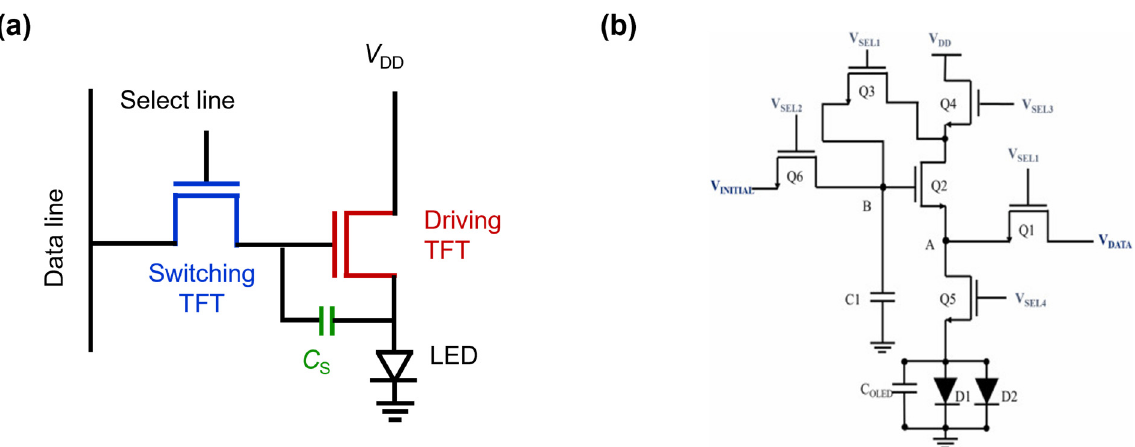
Figure 2. Schematic illustration for AM driving: ( a ) Typical 2T1C circuit and ( b ) 6T1C pixel compensation circuit (reproduced from [33] with permission from Elsevier).